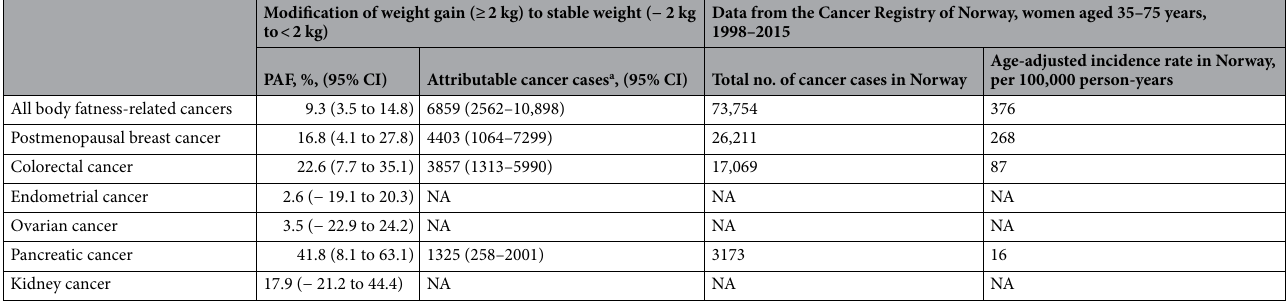
Table 3. Population attributable fractions and absolute number of cancer cases attributable to weight gain in women in Norway from 1998 to 2015. Attributable cancer cases were only calculated for outcomes with confidence intervals not including negative values. PAF population attributable fraction, CI confidence interval, NA not applicable. a The number of attributable cancer cases for all body fatness-related cancers is attenuated, as not all site-specific cancers under study were associated with weight